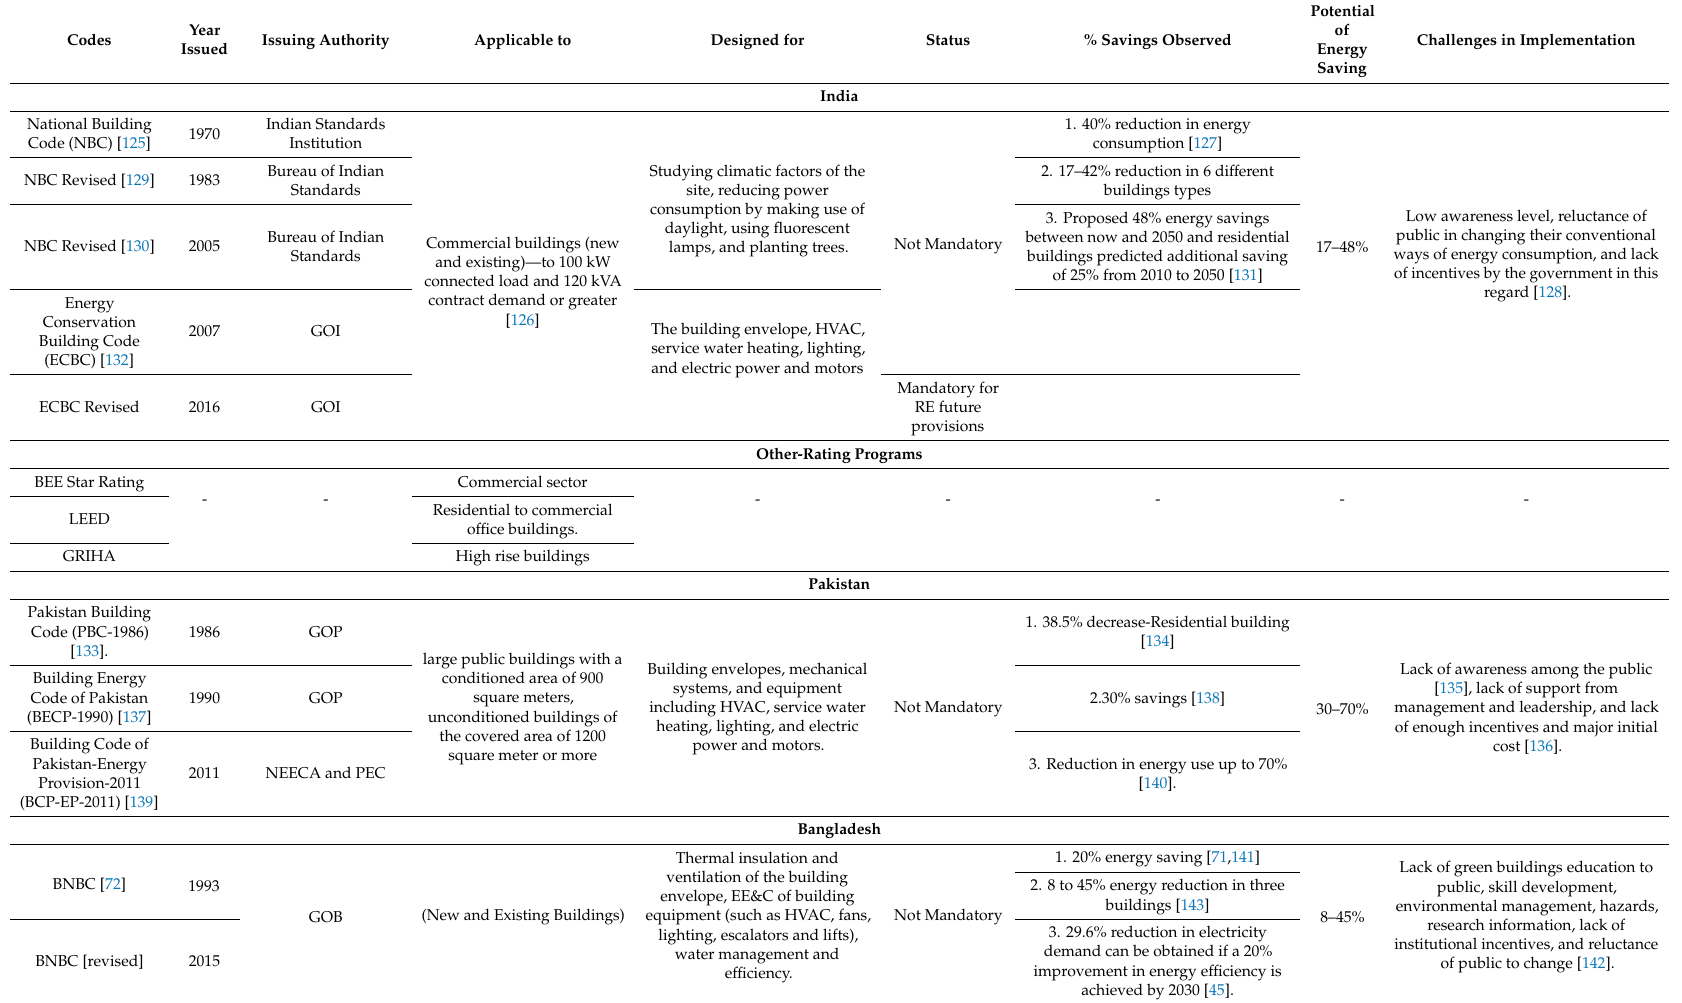
Table 3. BEECs of